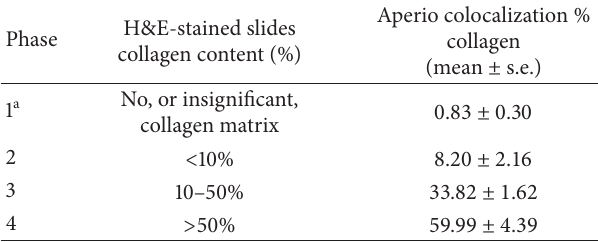
Table 1: Summary of individual tumor data. Table 2: Mean collagen content of phases 1–4.